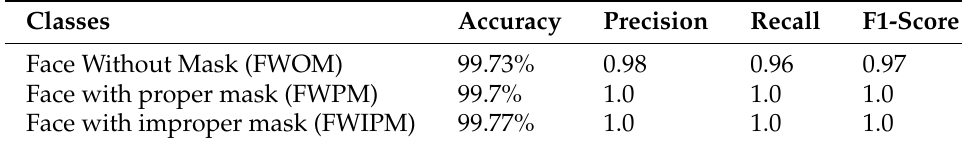
Table 5. Statistics using MobileNetV2 by classes.